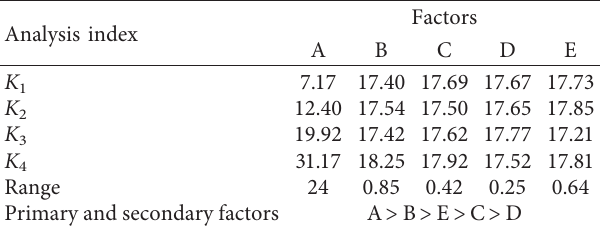
Table 10: Range analysis of the initial setting time of slurry.